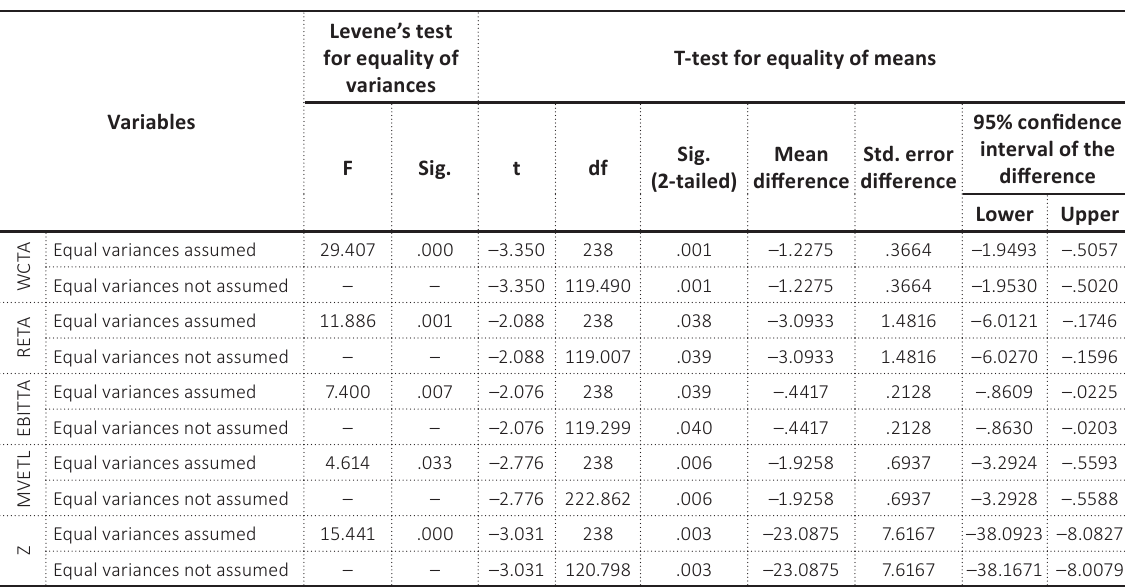
Table 2. Independence Samples T-test results of Group 1 and Group 2